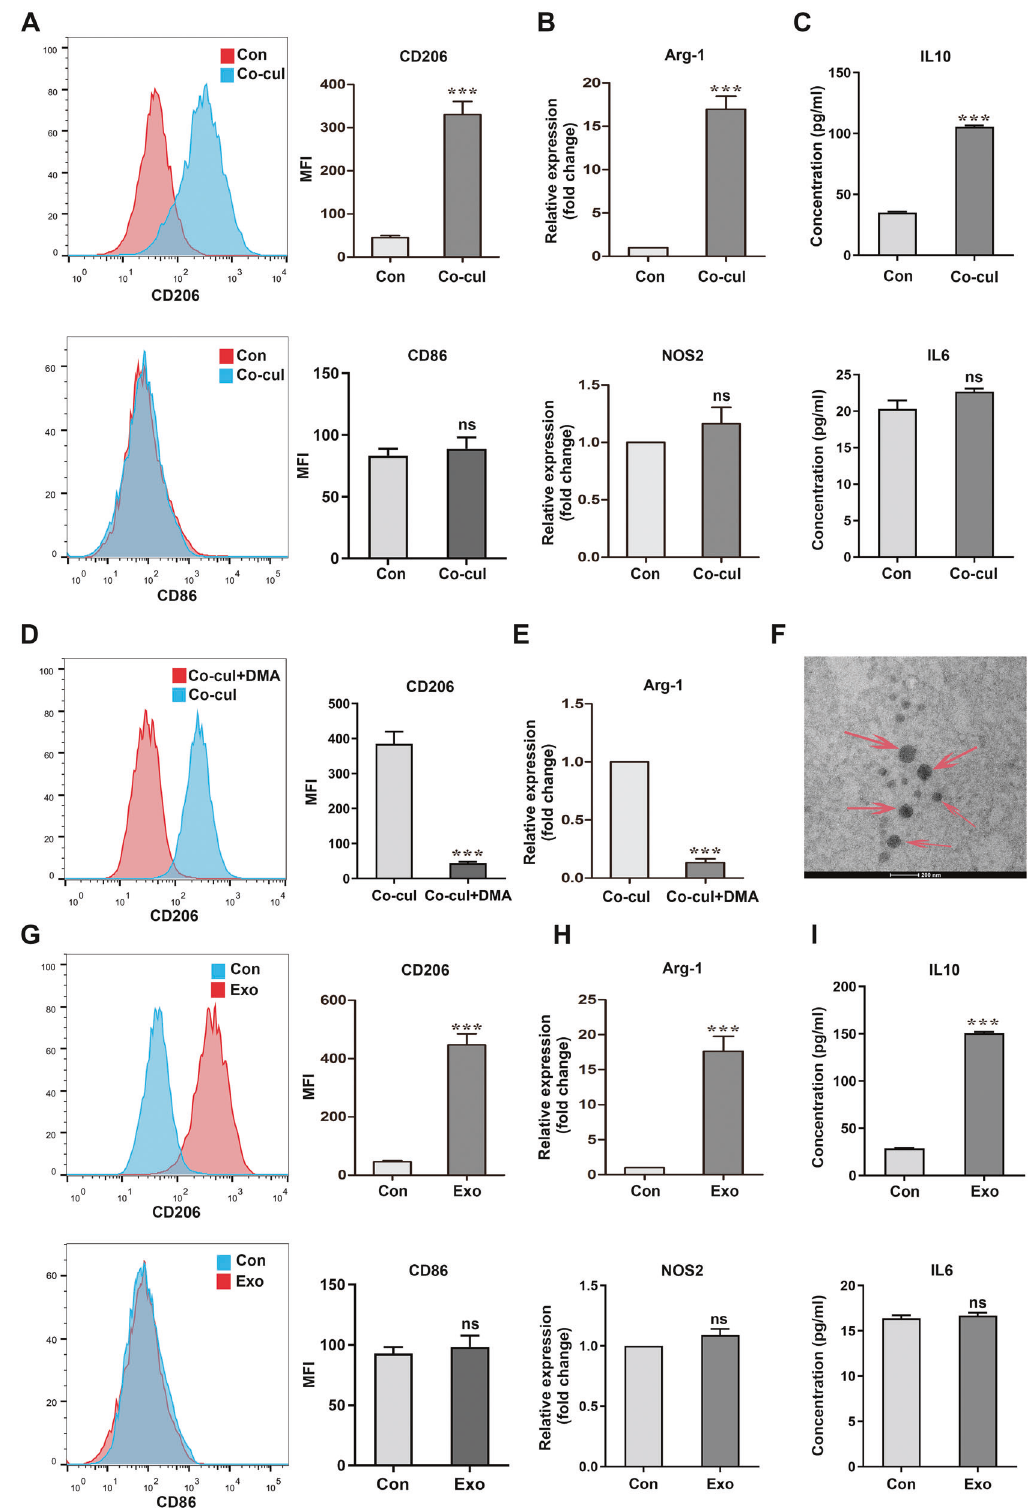
results indicated the presence of a higher percentage of both total and M2 MØ in mice injected with SCLC cells compared with those without, consistent with the above clinical data (Fig. 3D). To estimate the changes in the levels of the in fl ammasome proteins